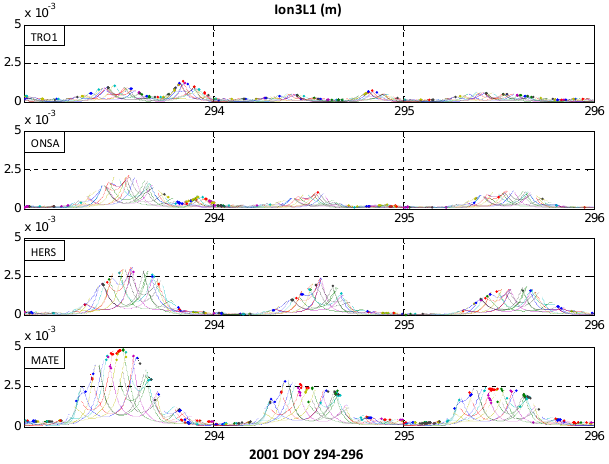
Fig. 6. Ion2 (m) for GPS L1 (Ion2L1) for the observation stations on DOY 294‐296 in 2001.